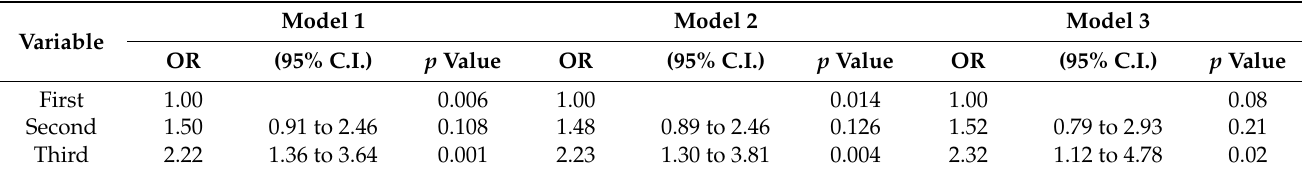
Table 5. Multiple logistic regression analysis of the association between homocysteine level and metabolic